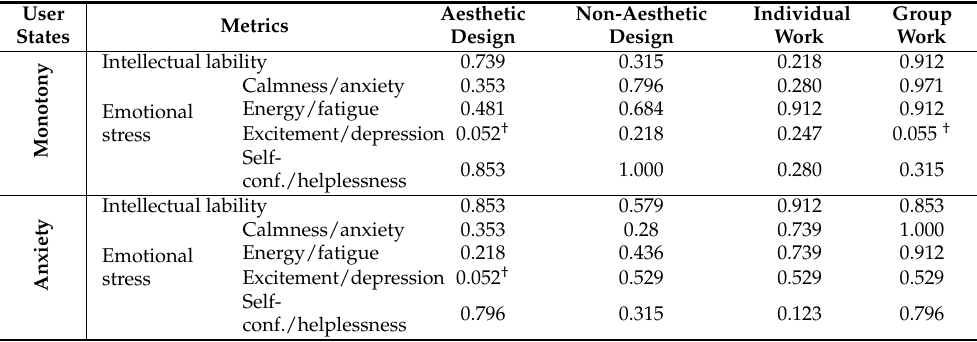
Table 2. p -values of the Mann-Whitney U-criterion for the ‘East’ vs. ‘West’ macro-groups, aesthetic vs. non-aesthetic design and individual vs. group